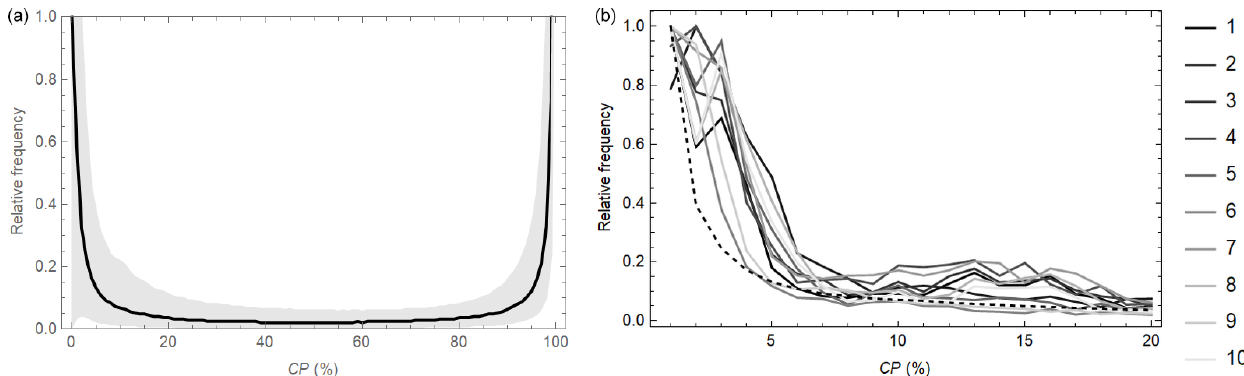
Figure 1. (a) The median (solid line) and the 80% variation range (grey shaded area) of the pixelwise cloud probability distributions for June 2012. Every fifth CP end-product pixel (0 . 25 ◦ × 0 . 25 ◦ ) available globally is included in the statistics. The frequencies are scaled with the median value at CP = 0%. (b) Ten largest pixelwise relative cloud probability distributions and the mean (dashed curve) of all CP distributions scaled with its maximum value. The solar zenith angle is restricted to not exceed 70 ◦ .